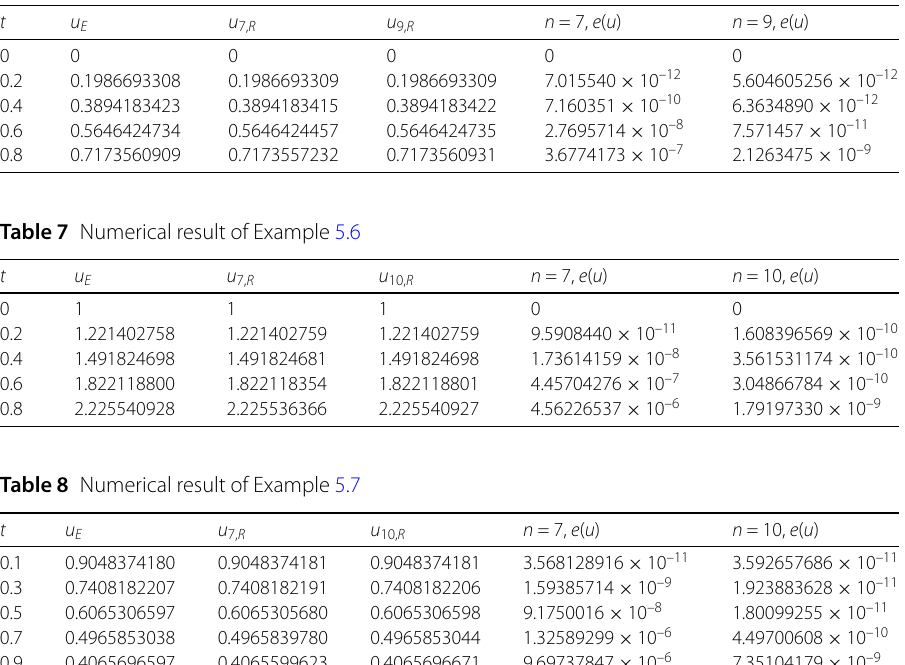
Table 6 Numerical result of Example 5.5